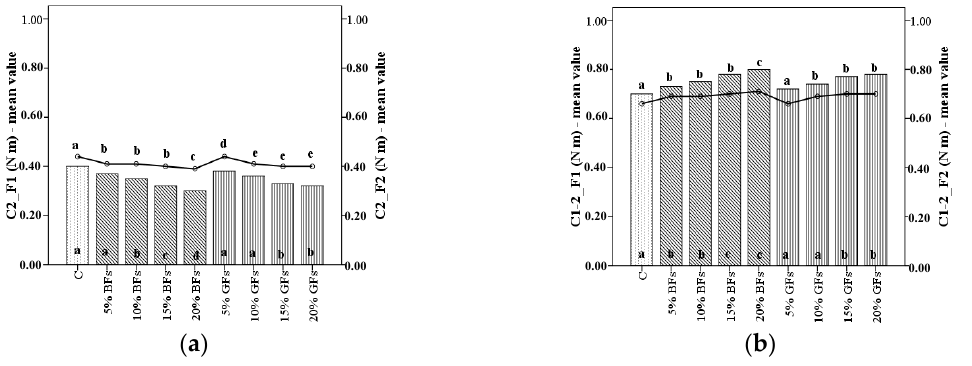
Figure 2. C2 torque ( a ) and difference between torques C1 and C2 (C1-2) ( b ) of WF (C) and flaxseed–wheat composite flours formulated by adding different levels (5%,10%,15% and 20%) of brown flaxseed (BFs) and golden flaxseed flour (GFs) in two types of flour—F1 and F2. Different letters indicate significant differences ( p < 0.05) between samples.